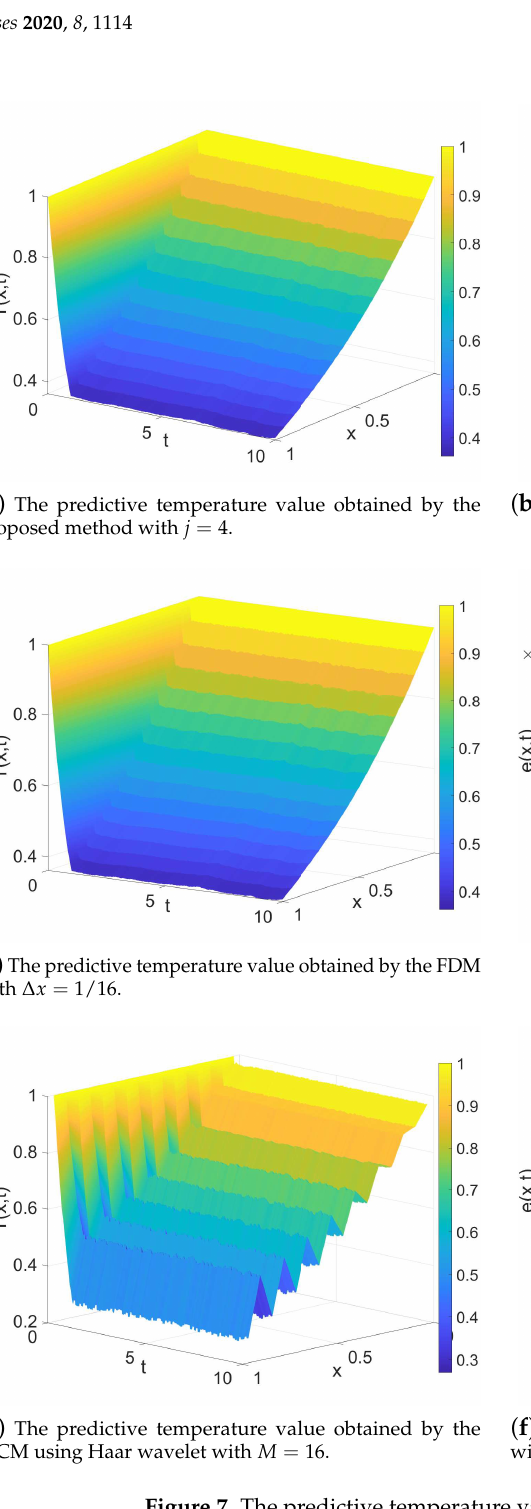
Figure 7. The predictive temperature value ( left ) and the errors ( right